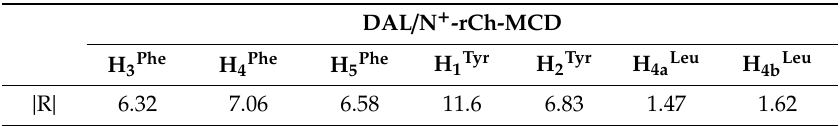
Table 3. Normalized relaxation rates ( | R | = (R 1mix − R 1free ) / R 1free ) of selected protons of DAL in the binary mixture DAL / N + -rCh-MCD.